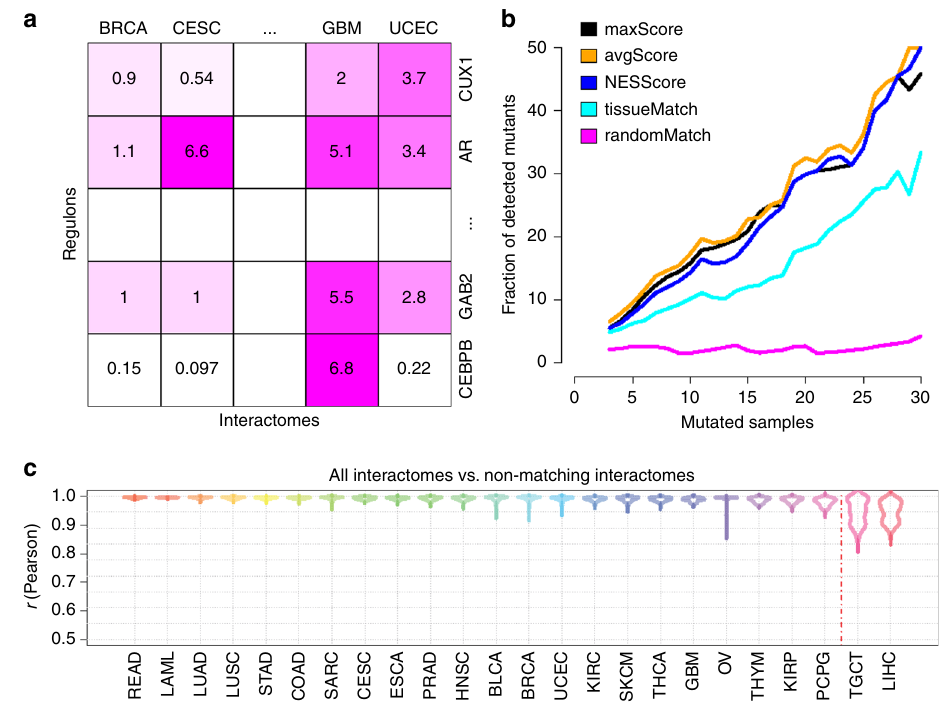
Fig. 1 Inferring protein activity with metaVIPER. a Overview of metaVIPER. The set of transcriptional targets for each regulatory protein (its regulon) constitutes the fundamental building blocks of an interactome, which re fl ect its overall, context-speci fi c regulatory control structure. MetaVIPER identi fi es the regulon that best recapitulates the regulatory targets of a protein by assessing its enrichment in the tissue-speci fi c differential expression signature. In the example shown here, for instance, the regulon for protein CUX1 in an unknown or orphan tissue is better recapitulated by the uterine corpus endometrial carcinoma (UCEC)-based regulon, while the transcriptional program for the androgen receptor protein (AR) is better recapitulated by the cervical squamous cell carcinoma and endocervical adenocarcinoma (CESC) and glioblastoma (GBM)-based regulons. The numbers indicate – log10( p - value) for enrichment of the regulons on the gene expression signature, as computed by VIPER. b Impact of recurrent coding somatic mutations on metaVIPER-inferred protein activity. Fraction of proteins showing signi fi cant association between metaVIPER-inferred protein activity and somatic mutations ( p < 0.01) is presented. VIPER analysis was performed using the tissue-matched network (tissueMatch), metaVIPER was performed by integrating the results from individual interactomes using maxScore, avgScore, and NESScore methods; the baseline control was computed by using intercatomes selected at random (randomMatch). The X -axis represents the minimum number of TCGA samples presenting the speci fi c gene mutation required for inclusion of the encoded protein in the analysis. c Inference of protein activity for orphan tissues. MetaVIPER can effectively reproduce differential protein activity in TCGA tissues, even when the corresponding matched interactome is removed from the analysis. The only partial exception is represented by two tissue lineages — liver hepatocellular carcinoma (LIHC) and testicular germ cell tumors (TGCT) — which are de fi ned by highly speci fi c regulatory programs. The probability density distribution for the correlation between protein activities (NES) inferred by metaVIPER using all available interactomes vs. metaVIPER using all, but the tissue-matched interactome (Pearson ’ s correlation) across all samples is shown by the violin